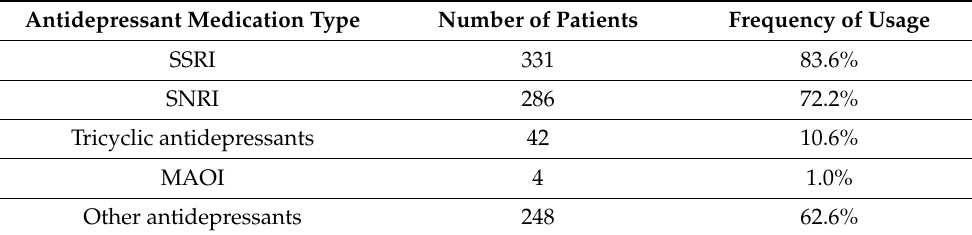
Table 4. Frequency of usage of different antidepressant types.